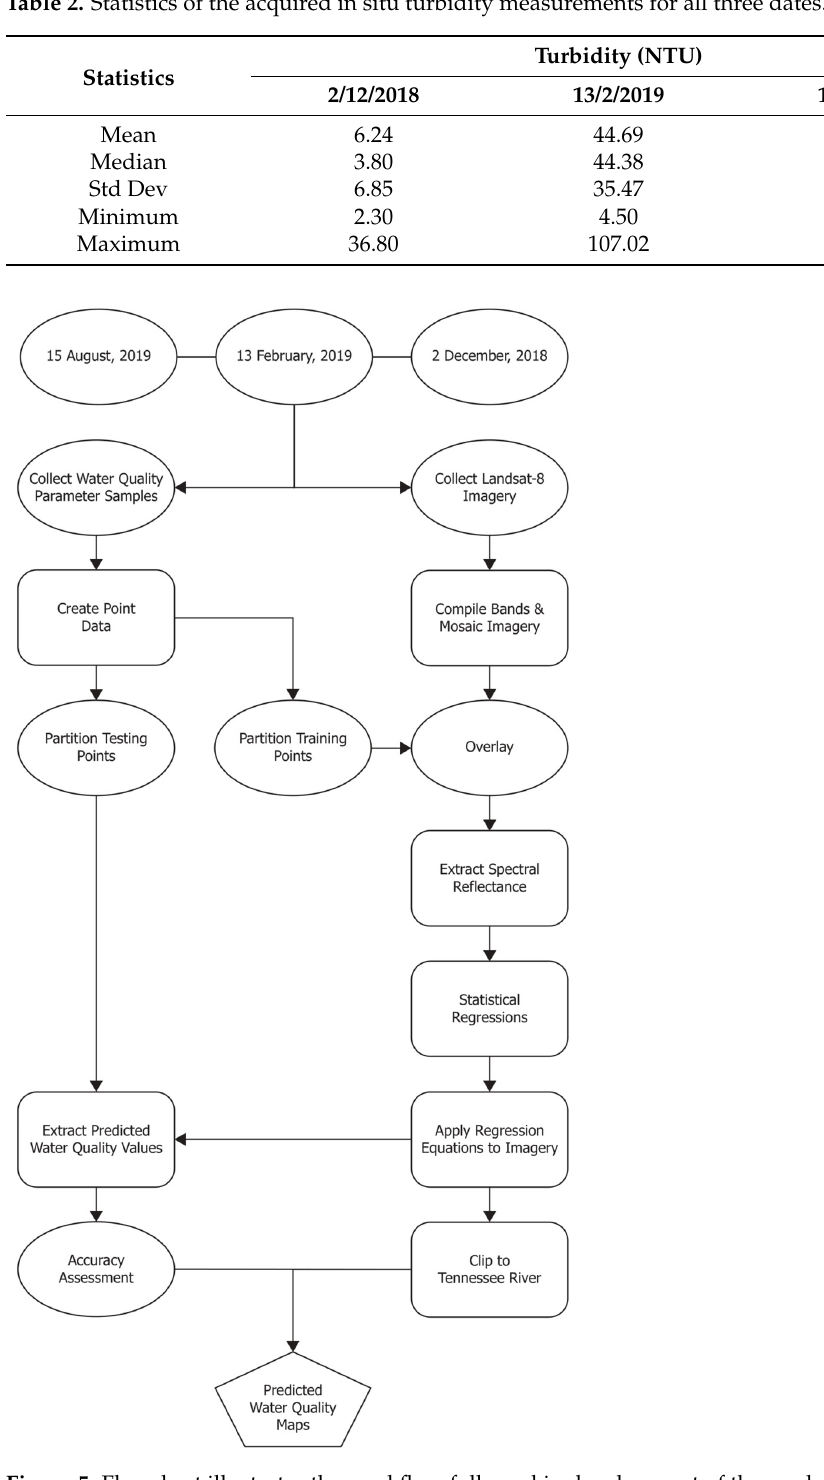
Figure 5. Flowchart illustrates the workflow followed in development of the